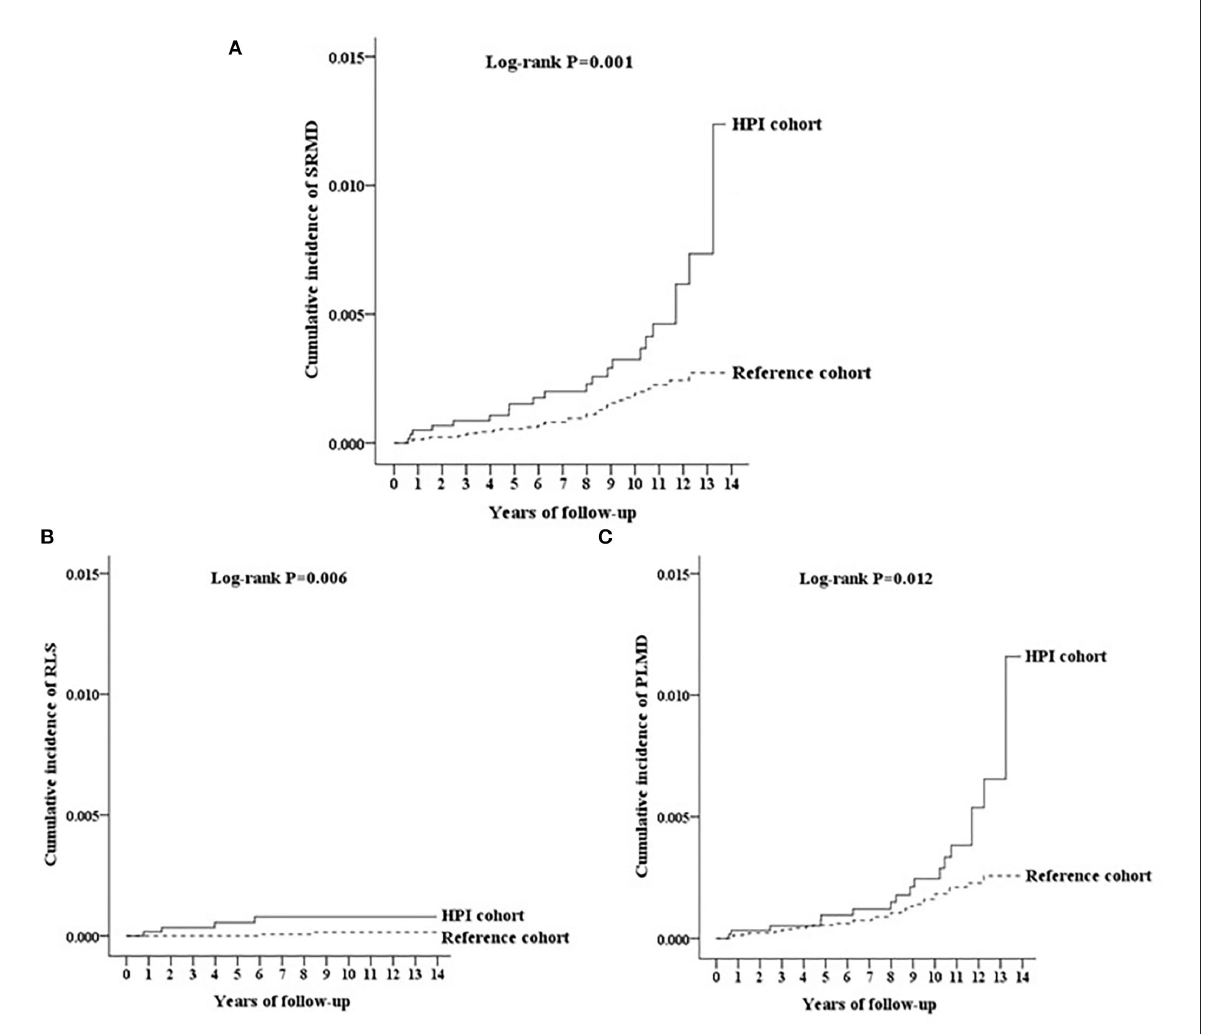
FIGURE2 (A) The cumulative incidence curves of sleep-related movement disorders (SRMD) for individuals with and without Helicobacter pylori infection (HPI). (B) The cumulative incidence curves of restless legs syndrome (RLS) for individuals with and without HPI. (C) The cumulative incidence curves of periodic limb movement disorder (PLMD) for individuals with and without